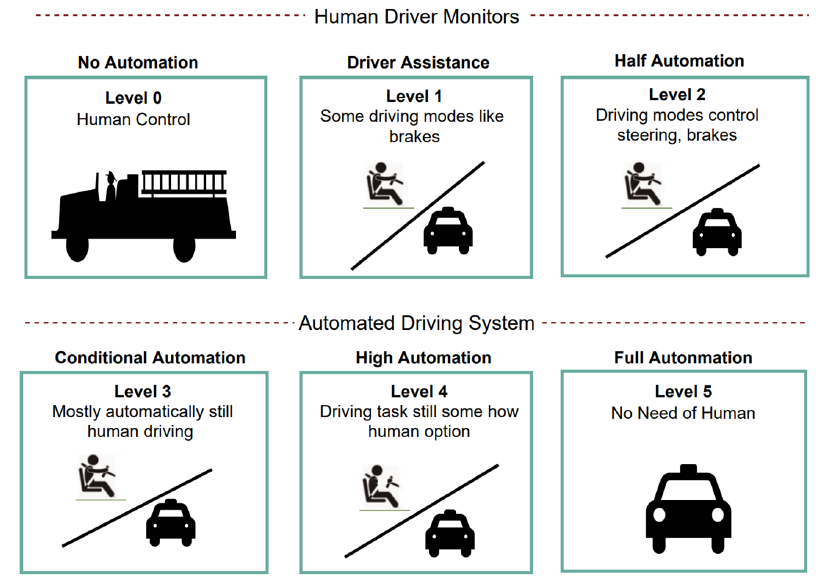
Figure 1. Six levels of AVs: Monitoring by a human driver ( Top ) comprising three subparts—no automation, driver assistance, and half automation—and an automated driving system ( Bottom ) comprising three subparts—conditional, high, and full